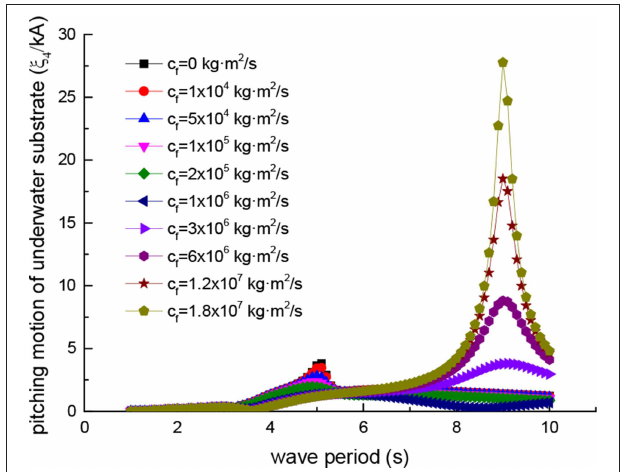
FIGURE 12 | Wave period of test time.